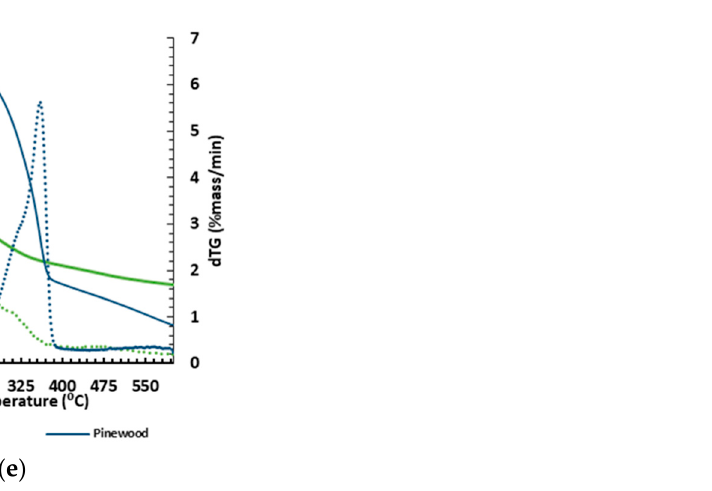
Figure 6. TGA (solid lines) and DTG (dashed lines) curves for the different biomasses: ( a ) bark; ( b ) sapwood; ( c ) heartwood; ( d ) branches; ( e ) pinewood, and their corresponding bio-oils.